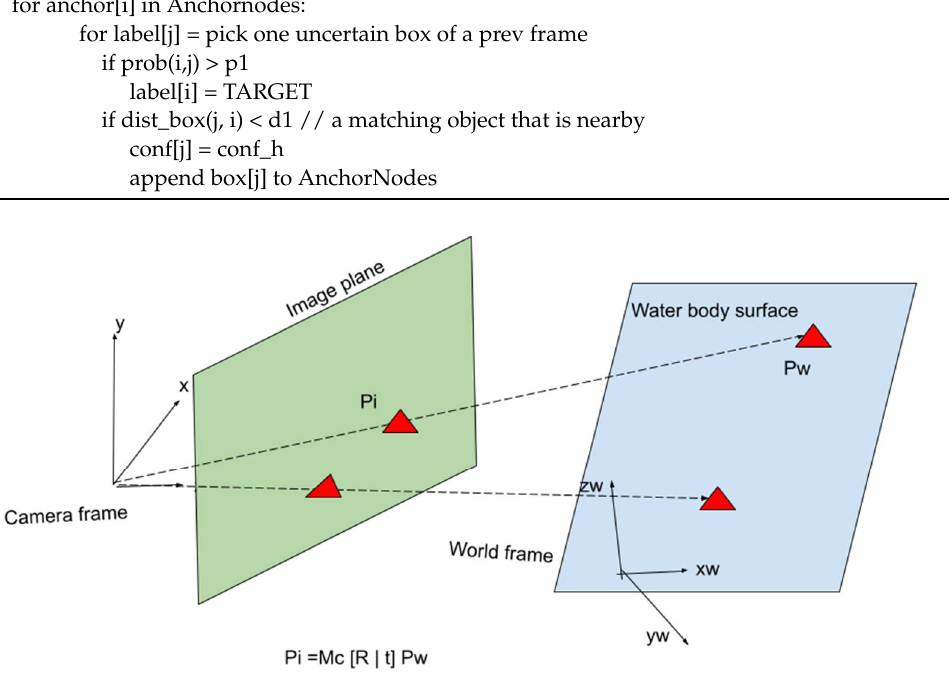
Figure 7. Perspective projection of co-plane objects projected onto the image plane. Here, [ R | t ] is the transformation from the world frame to the camera frame.